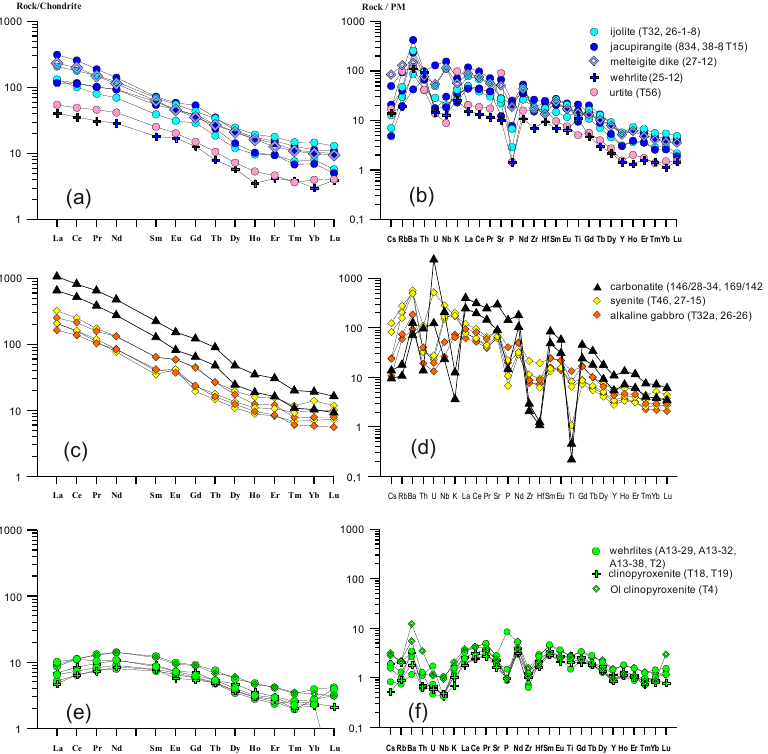
Figure 3. REE and trace-element distribution patterns for rocks of the Tiksheozero Complex. Concentrations are normalized to chondrite and primitive mantle after [36]. ( a , b ) highly silica-undersaturated ultramafic alkaline rocks (jacupirangites, foidolites) (group 1); ( c , d ) silica-undersaturated alkaline rocks (alkaline gabbro, nepheline syenite) (group 2) and carbonatites (group 3); ( e , f ) ultramafic-mafic rocks of the mildly alkaline series (dunites, wehrlites, clinopyroxenites) (group 4). Data on samples T18, T19, 26-1-8, 38-8, 27-12, 25-12, T56, 26-26 are taken from [17]. Compared to the mildly alkaline ultramafic-mafic rocks, the highly silica-undersaturated ultramafic alkaline rocks are characterized by the insignificant variations at lower SiO 2 content (39.21 to 43.85 wt %), higher Na 2 O predominating over K 2 O, lower MgO (7.37 to 12.57 wt %), higher TiO 2 (1.96–4.35 wt %) and P 2 O 5 (up to 0.61 wt %), and much lower Ni (417.7 to 21.45 ppm) and Cr contents (478 to 9.57 ppm). All the rocks are characterized by the elevated contents of Ba, LREE, and Ti. They have fractionated REE patterns with moderate to high LREE enrichment relative to HREE ((La/Yb) N = 12.19–27.50; (La/Sm) N = 1.54–4.31 and (Gd/Yb) N = 3.62–5.47). Spidergrams show a deep negative P anomaly, negative Nb anomaly, depletion in Th and U, a positive Ba anomaly, and shallow Zr-Hf anomaly (Figure